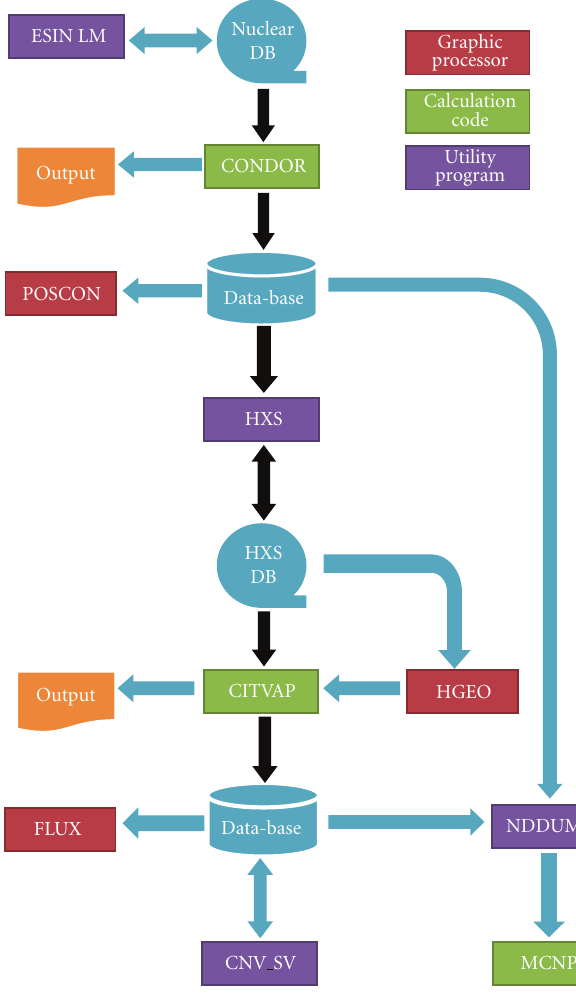
Figure 1: INVAP’s nuclear calculation